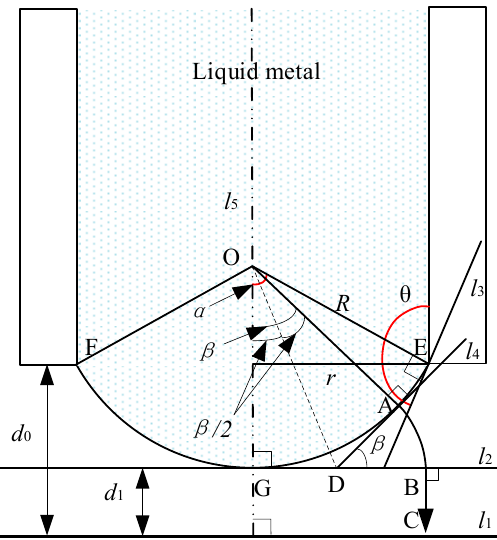
Figure 4. Electric field force of the liquid-metal electrode